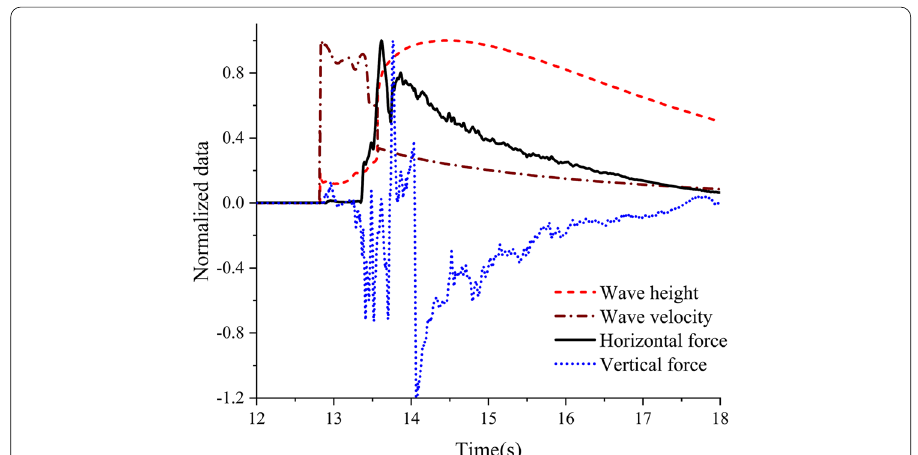
Fig. 12 The relationship between tsunami force, bore height and bore velocity at x normalized by its maximum